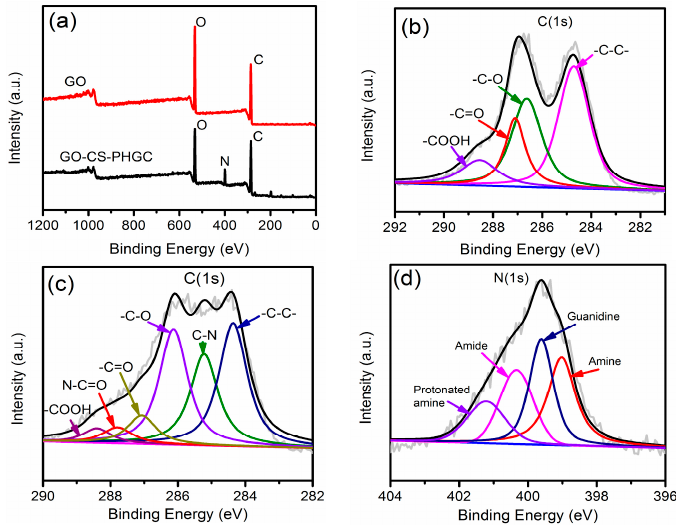
Figure 4. ( a ) XPS spectra of GO and GO-CS-PHGC; C 1s spectra of ( b ) GO and ( c ) GO-CS-PHGC with deconvoluted peaks; N 1s of ( d ) GO-CS-PHGC with deconvoluted peaks.